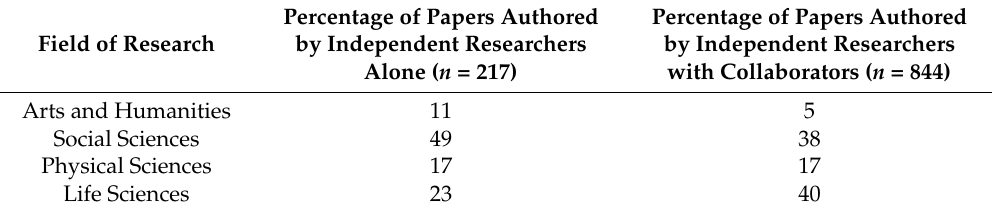
Table 2. Distribution of papers authored by independent researchers based on research field (using the first classification code provided by Scopus 1